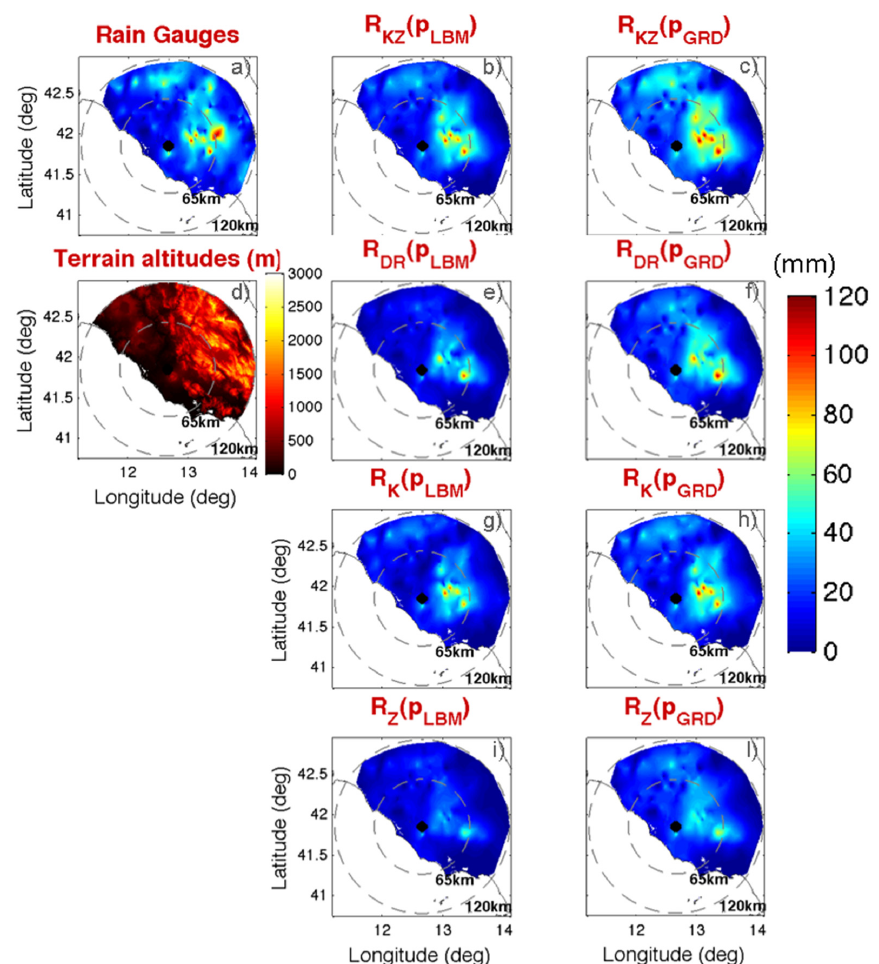
Figure 6. Qualitative comparison between rain gauge accumulations within 24 h (top left) and rain P55C-radar accumulations using various rain estimators as specified in each of the panel’s title. Panels in the middle column refer to the implementation of Equations (1)–(4) whereas panels on the right side refer to the use of Equation (7). The rain accumulations are obtained summing those registered on 12 October 2012, 15 October 2012, and 14 October 2015 at each gauge position. To improve the qualitative comparison among the various estimators implemented, in each panel a spatial interpolation is applied starting from the rain accumulations extracted at the positions of the rain gauges.